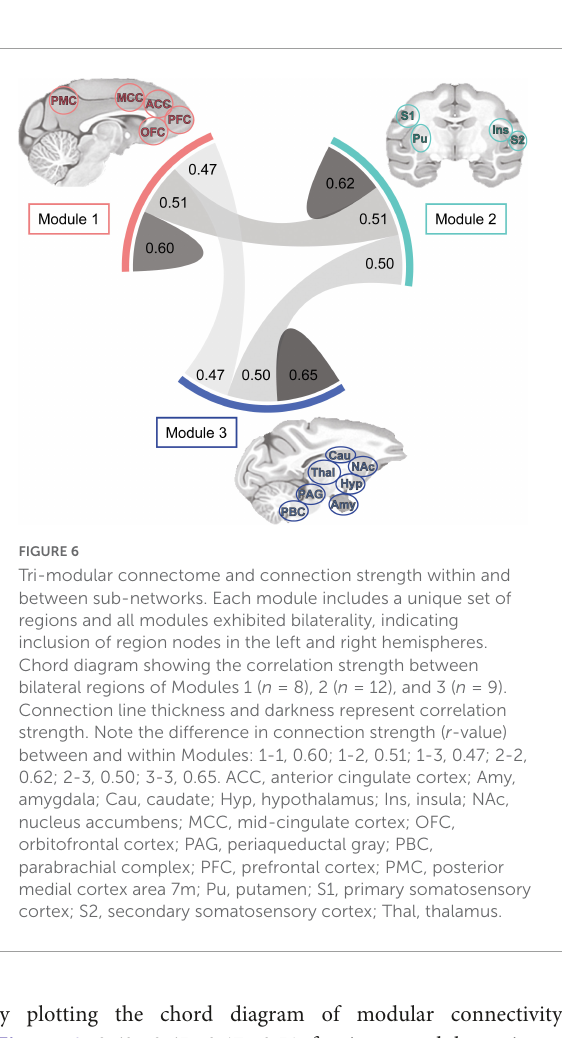
by plotting the chord diagram of modular connectivity ( Figure 6 , 0.60 − 0.65, 0.47 − 0.51 for intra-module vs